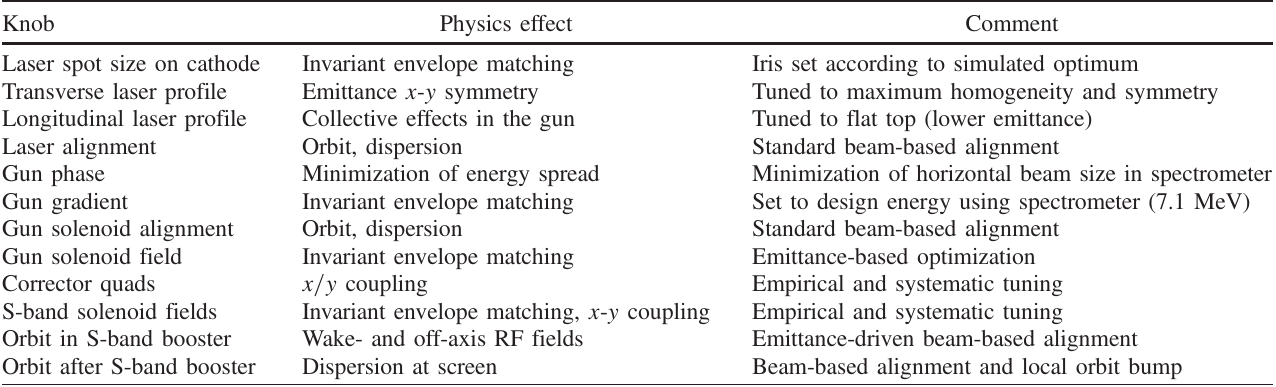
TABLE I. A summary of “ knobs ” used for emittance minimization. Knob